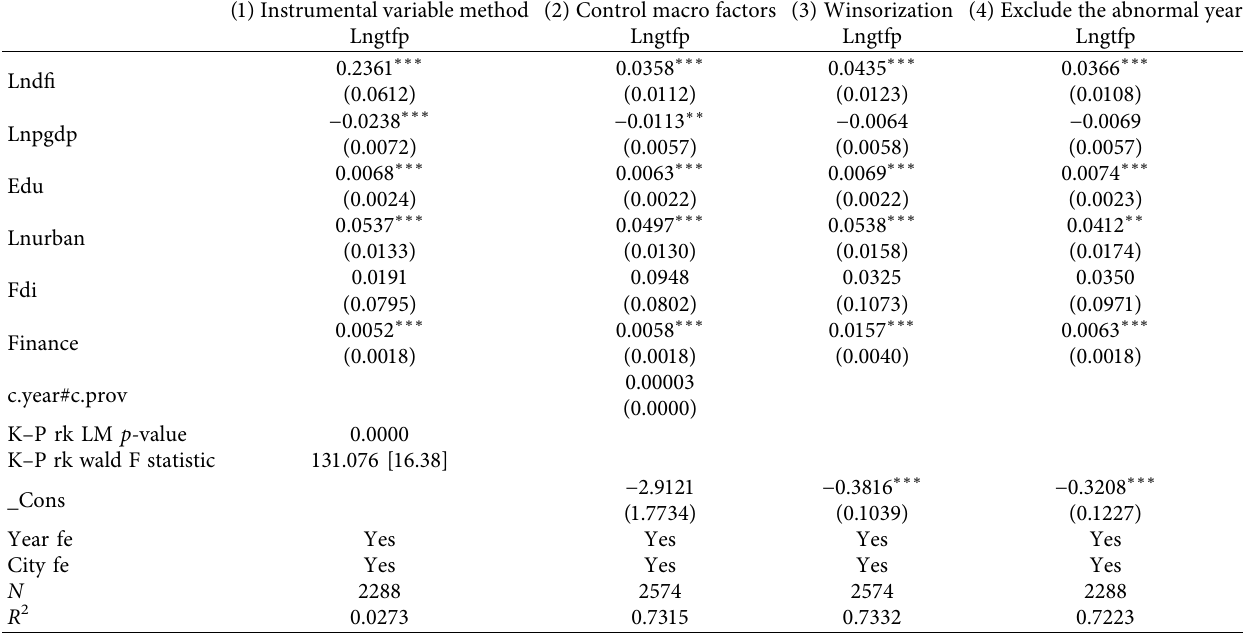
Table 4: Endogenous treatment and robustness